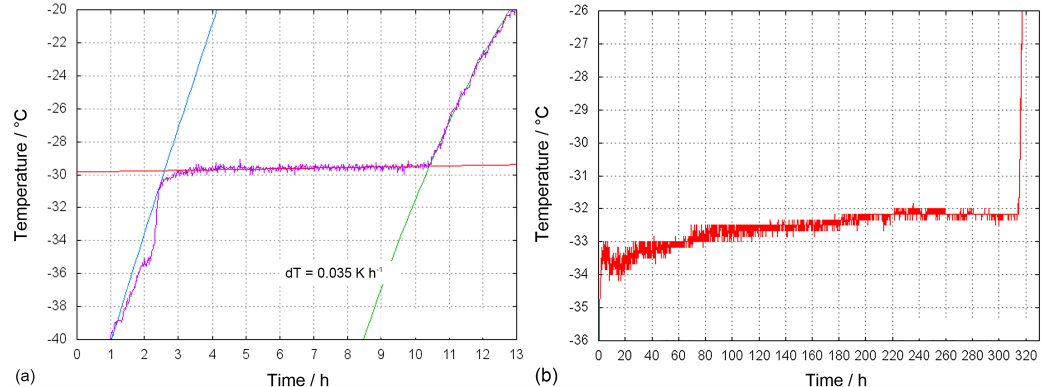
Figure 4. Lab test of the melting plateau at an ambient pressure of about 1013hPa and an ambient temperature of about 23 ◦ C (a) ; and a thermal-vacuum test of the BBB at ambient pressure of 10hPa and ambient temperature of about − 22 ◦ C (b)